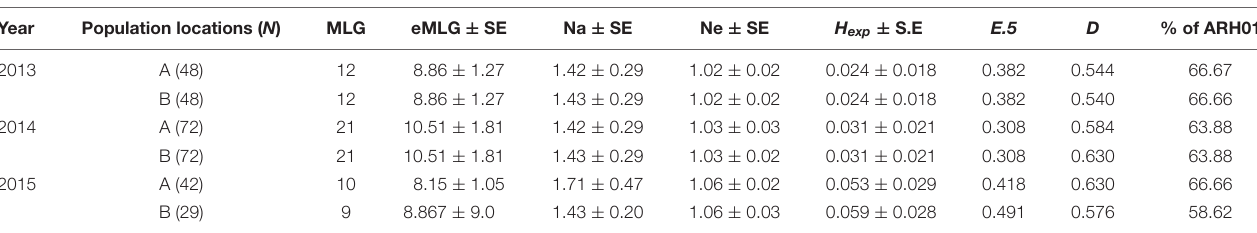
TABLE 6 | The genetic structure of the population detected within each of the six growing